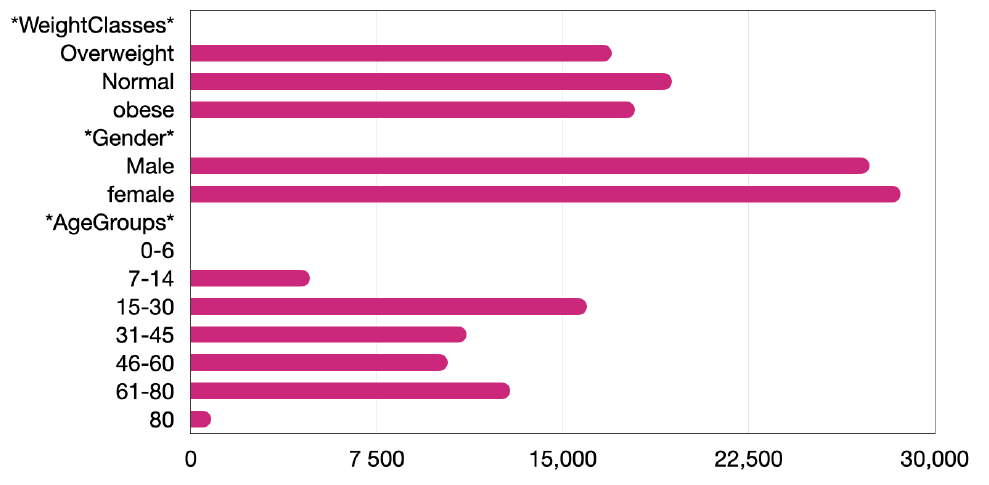
Figure 1. Characteristics of sample.